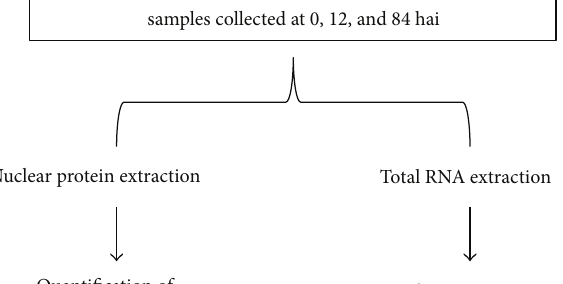
Table 2: Primer sequences utilized for